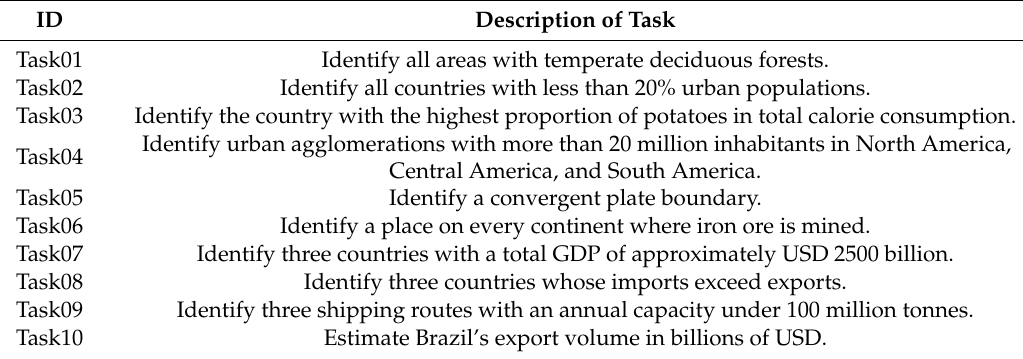
Table 1. List of the experiment’s tasks (translated from Czech to